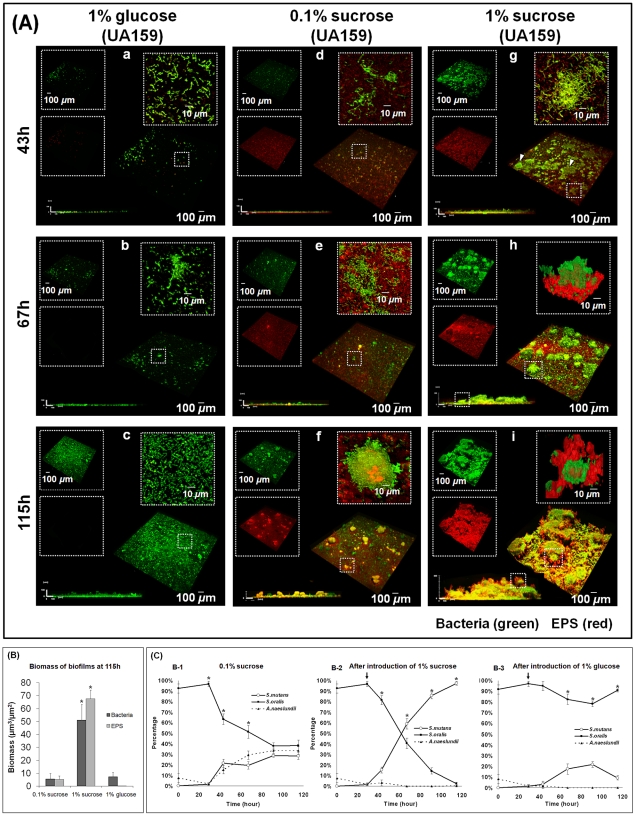
Dynamics of the morphogenesis, 3D architecture development and microbial population shifts of mixed-species biofilms.(A) Representative 3D rendering images of mixed-species biofilms at distinct time points. Images (a–c) represent biofilms formed after the introduction of 1% (w/v) glucose. Images (d–f) represent biofilms formed in the presence of 0.1% (w/v) sucrose. Images (g–i) represent biofilms formed after the introduction of 1% (w/v) sucrose. The EPS channel is depicted in red, while the cells are depicted in green. At the upper left of each panel, the two channels are displayed separately, while the merged image is displayed at the bottom right. Lateral (side) views of each biofilm are displayed at the bottom left, while a magnified (close-up) view of each small box depicted in the merged image is positioned in the upper right corner of each panel. (B) The data are mean values ± s.d. (n = 30). The asterisks (*) indicate that the each of the values (EPS and bacterial biomass) in the 1% sucrose group are significantly different from others (P<0.05, Tukey-Krammer HSD). (C) Bacterial species [S. mutans (102 CFU/ml), A. naeslundii (106 CFU/ml), and S. oralis (107 CFU/ml)] were inoculated in the culture medium supplemented with 0.1% (w/v) sucrose until 29 h for establishment of the initial biofilm community [S. oralis (5.6±3.5×106 CFU), A. naeslundii (9.4±6.5×104 CFU) and S. mutans (8.8±2.5×103 CFU)]. The biofilms were then challenged with an environmental change by introducing 1% (w/v) sucrose (B-2) or 1% (w/v) glucose (B-3). Viable populations of S. mutans, S. oralis, and A. naeslundii recovered from the biofilms were counted (number of CFU recovered per biofilm) over time, and the proportion of each strain at each time point was calculated based on CFU data. Microbial population at 115 h in: 1% sucrose (1.1±0.2×1011 CFU of S. mutans; 2.1±2.9×109 CFU of S. oralis; 1.7±0.4×107 CFU of A. naeslundii), 0.1% sucrose (6.7±0.8×109 CFU of S. mutans; 1.4±1.9×1010 CFU of S. oralis; 9.3±1.3×109 CFU of A. naeslundii), and 1% glucose (2.6±1.9×109 CFU of S. mutans; 3.2±0.4×1010 CFU of S. oralis). The data are mean values ± s.d. (n = 12). The asterisks (*) indicate that the values from each strain are significantly different from each other (P<0.05).